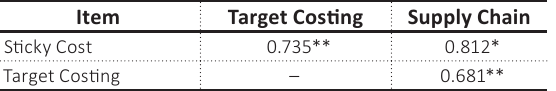
Table 2. Correlation